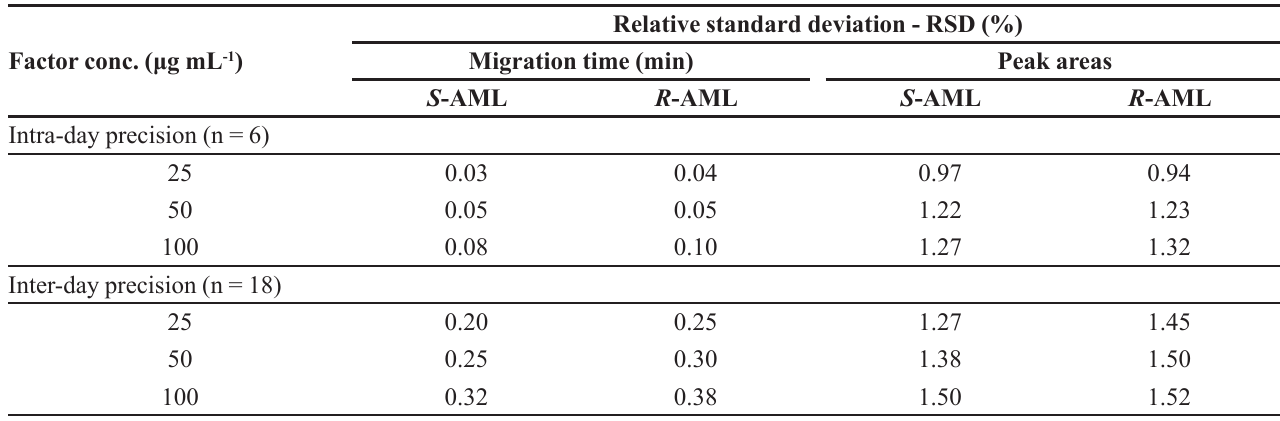
TABLE II - Intra-day and inter-day reproductibility data for repeated injections of different concentrations of racemic AML standard